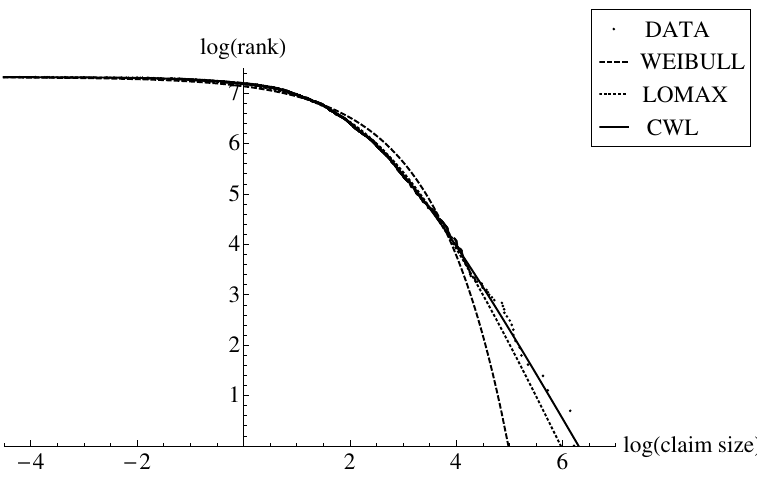
Figure 1. Relationship between claim rank and claim size in log–log scale and graphs of the inverse of the survival function of Weibull (W, dashed), Lomax (L, dotted) and composite Weibull–Pareto (CWL, solid) distributions.